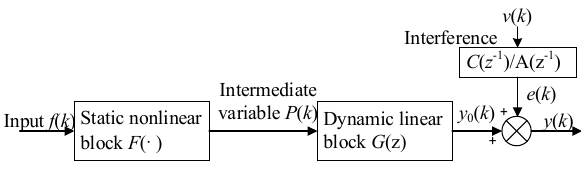
Figure 5. The structure diagram of Hammerstein model.